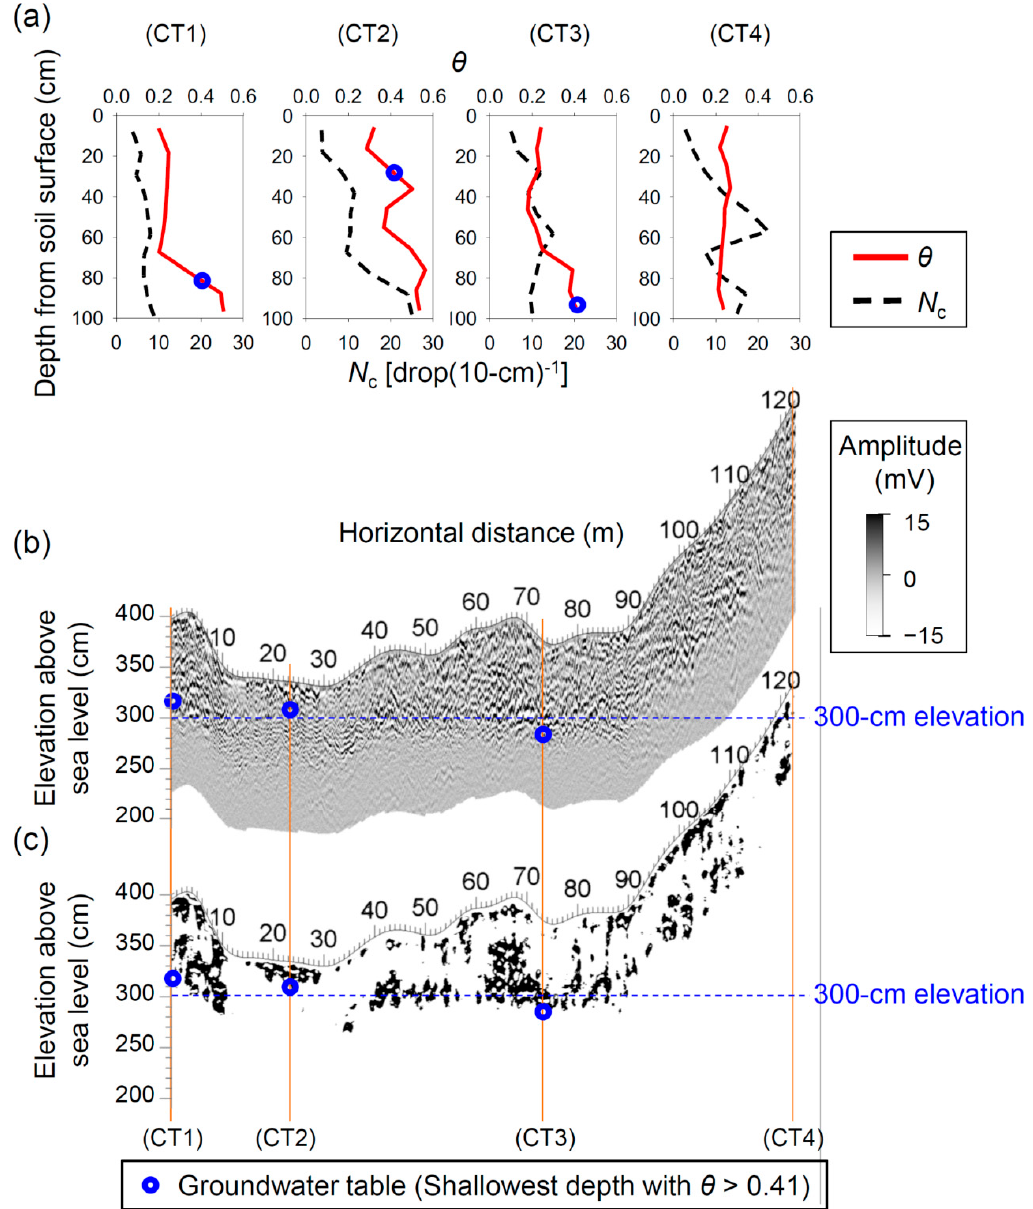
Figure 4. ( a ) Vertical profiles of θ and N C measured by the CPMP, ( b ) radargram, and ( c ) the area in which the median amplitude within a radius of five pixels was > 15 mV in the radargram at the CT site.